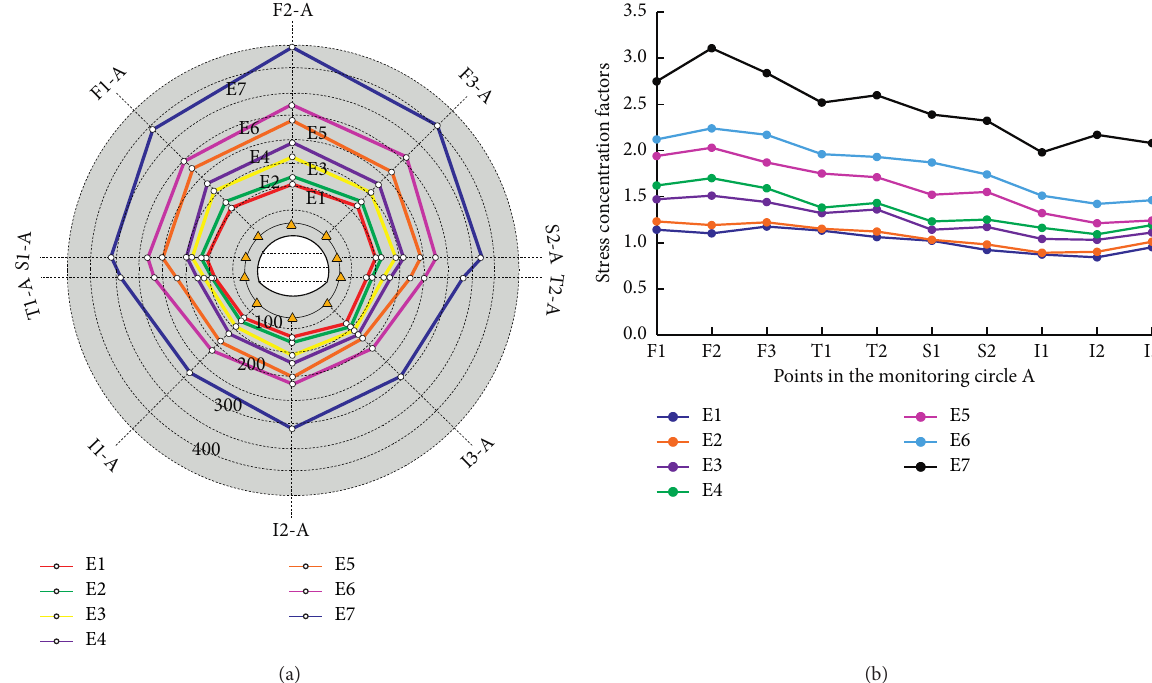
Figure 16: (a) Temporal and spatial distribution of maximum principle stresses of the monitoring circle A around the tunnel; (b) evolution of stress concentration factors of the monitoring points.